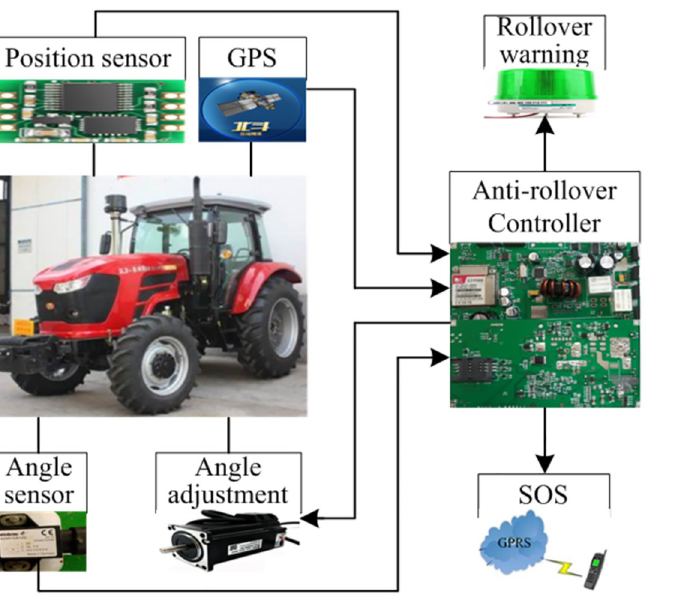
Fig 1. Architecture of rollover prevention